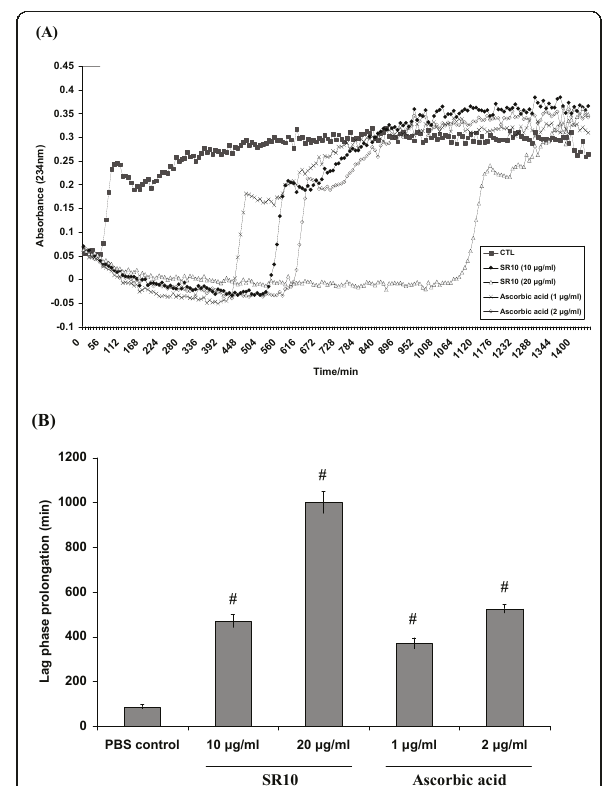
Figure 2 Effect of SR10 on prolongation of copper ion-induced LDL oxidation . LDL in PBS was incubated with 5 μ M CuCl 2 at 37°C in the presence or absence of SR10, and ascorbic acid (positive control). Conjugated diene formation was measured by determining the absorbance at 234 nm at every 5 minutes for totally 24 hours. A figure showing one representative experiment of three trials was shown in panel A. Lag time was determined as the intercept of the slopes for the lag phase and propagation phase. Difference of lag time between treatment and control (PBS only) was defined as lag phase prolongation. Results of lag phase prolongation time from three independent trials was shown in panel B. Values are expressed as mean ± S.D. for three independent experiments. By Mann- Whitney test, significant difference when compared to PBS control was indicated by # p <